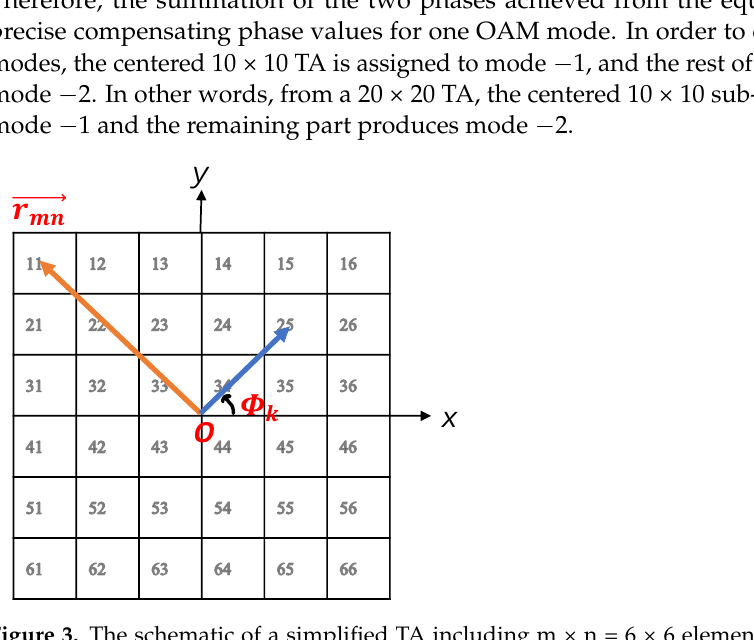
Figure 3. The schematic of a simplified TA including m × n = 6 × 6 elements to demonstrate the variables of Equation